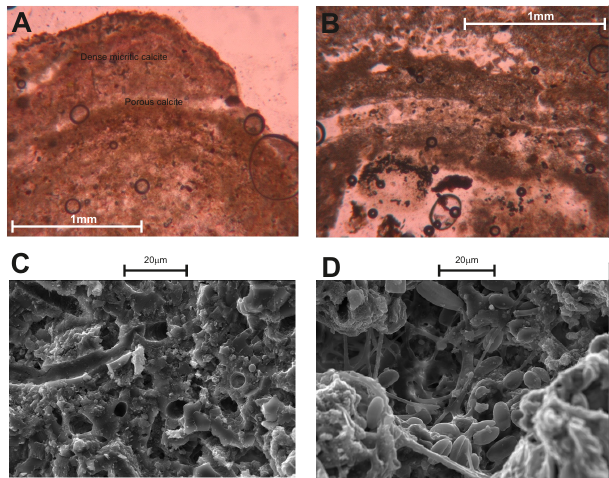
Figure 11. Photomicrographs of tufa deposit from Stainton, Lin- colnshire, UK. (A) and (B) transmitted-light images showing alter- native layers of micrite and porous calcite. (C) SEM image showing tubular holes in calcite left by loss of cyanobacterial filaments. (D) clotted calcite bodies with cyanobacterial filaments and diatoms in the centre of the